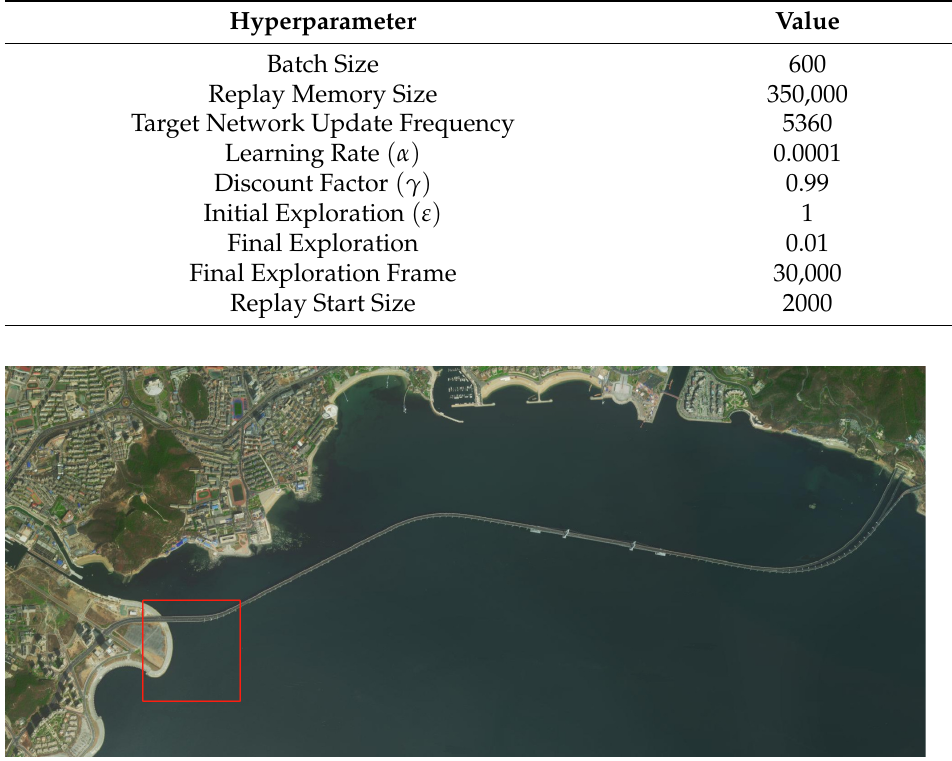
Table 2. Hyperparameters of reinforcement learning.